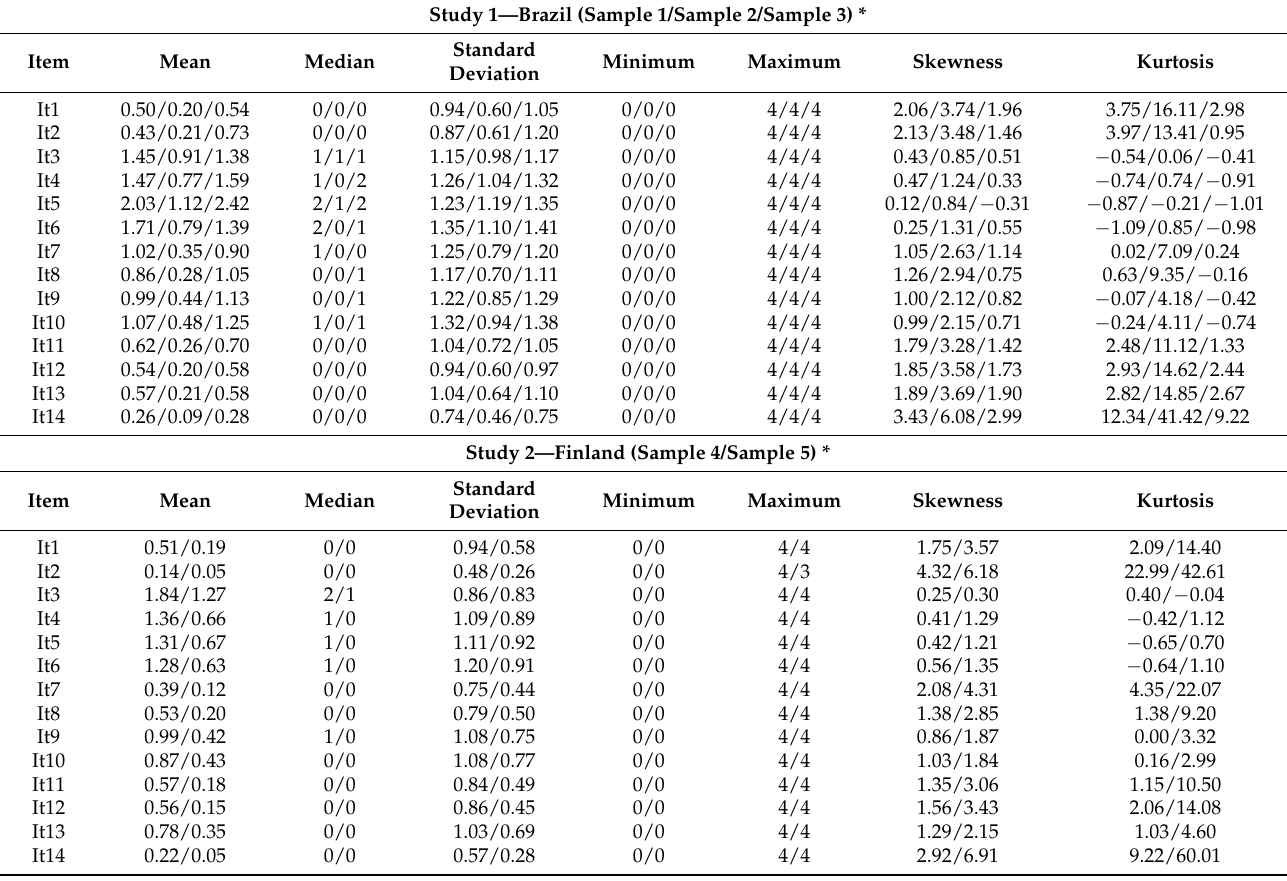
Table 2. Descriptive statistics of the responses given to the items of the Oral Health Impact Profile-14 by the participants of each